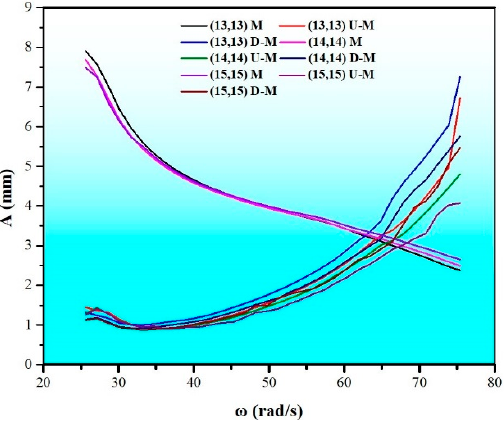
Figure 11. Influence of stiffness variation on amplitude-frequency characteristic curves: (a) X, 13, (b) X, 14, (c) X, 15.